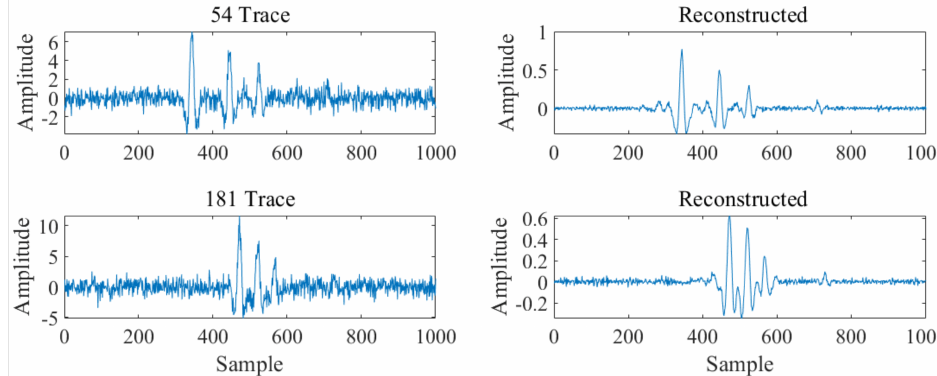
Figure 7. Single-trace contrast before and after outlier denoising.